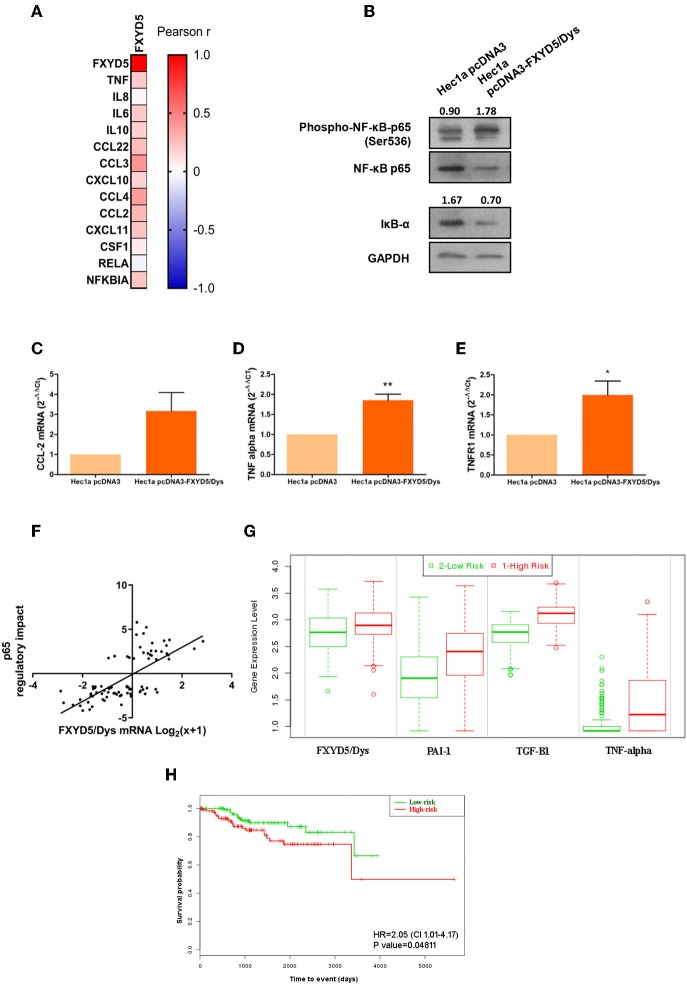
FXYD5/Dys expression and NF-κB pathway activation. (A) Correlation analysis between FXYD5/Dys and NF-κB pathway-related genes. A heatmap was built based on Pearson r correlation values for each gene. (B) Evaluation of NF-κB pathway activation by Western immunoblotting. A representative image of p65 total and phosphorylated protein forms and IκB-α total protein form is shown. Antibodies: NF-κB p65 (monoclonal C22B4 # 4764, 1:1,000 dilution), phospho-NF-κB p65 (Ser536) (monoclonal 93H1 # 3033, 1:1,000 dilution), and IκB-α (polyclonal # 9242, 1:1,000 dilution). (C–E) RT-qPCR analysis of CCL-2 (C) (P = 0.0654), TNF-α (D) (P < 0.05), and TNFR1 (E) (P < 0.01) (Wilcoxon signed-rank test) in Hec1a pcDNA3 and Hec1a pcDNA3-FXYD5/Dys cells. (F) Correlation analysis between FXYD5/Dys mRNA levels and transcriptional activation of genes regulated by p65. Regulatory impact of p65 transcription factor on tumor-specific gene expression patterns from EC samples from the TCGA-UCEC study. p65 regulatory impact to gene expression in each tumor is represented as a linear model t-value: a positive t-value indicates p65 upregulates its target genes, and a negative t-value indicates p65 downregulates its target genes. FXYD5/Dys mRNA levels are expressed as log2(x + 1) were x is the RSEM normalized expression value (Spearman correlation, r = 0.6927, N = 81). (G,H) SurvExpress tool used to evaluate the impact of FXYD5/Dys, PAI-1, TGF-β1, and TNF-α mRNA levels upon EC patient survival. This analysis was performed using gene expression and survival data of EC samples from the TCGA-UCEC study (N = 332). A prognostic index was estimated by beta coefficients multiplied by gene expression values of the four genes included in the analysis. Then, EC samples were divided into “low-risk” and “high-risk” groups according to their prognostic index values. (G) Box plots generated by SurvExpress showed the mRNA expression levels of FXYD5/Dys, PAI-1, TGF-β1, and TNF-α. The P-value from a t-test of the difference between low- and high-risk groups was also calculated for each gene: FXYD5/Dys, P = 3.80e−03; SERPINE1, P = 2.05e−08; TGF-β1, P = 1.47e−24; and TNF, P = 3.79e−10. Low risk was in green, and high risk was in red. (H) Kaplan–Meier survival curves were constructed to evaluate the impact of FXYD5/Dys, PAI-1, TGF-β1, and TNF-α mRNA levels (low- and high-risk groups) upon EC patient survival (log-rank test).